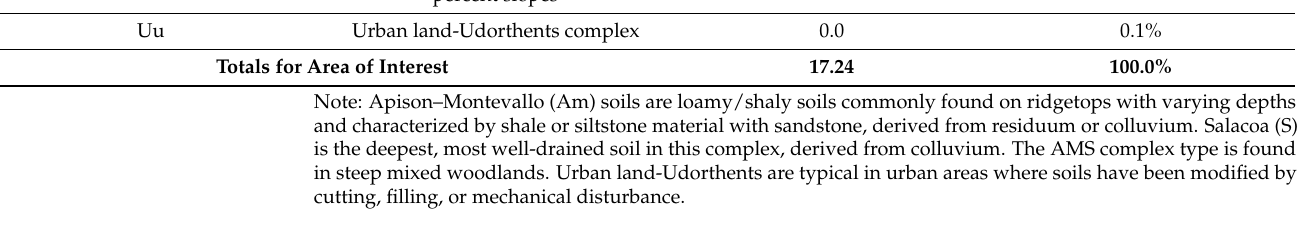
Table A2 . Coordinates of 17 ecological sampling plots in this study.